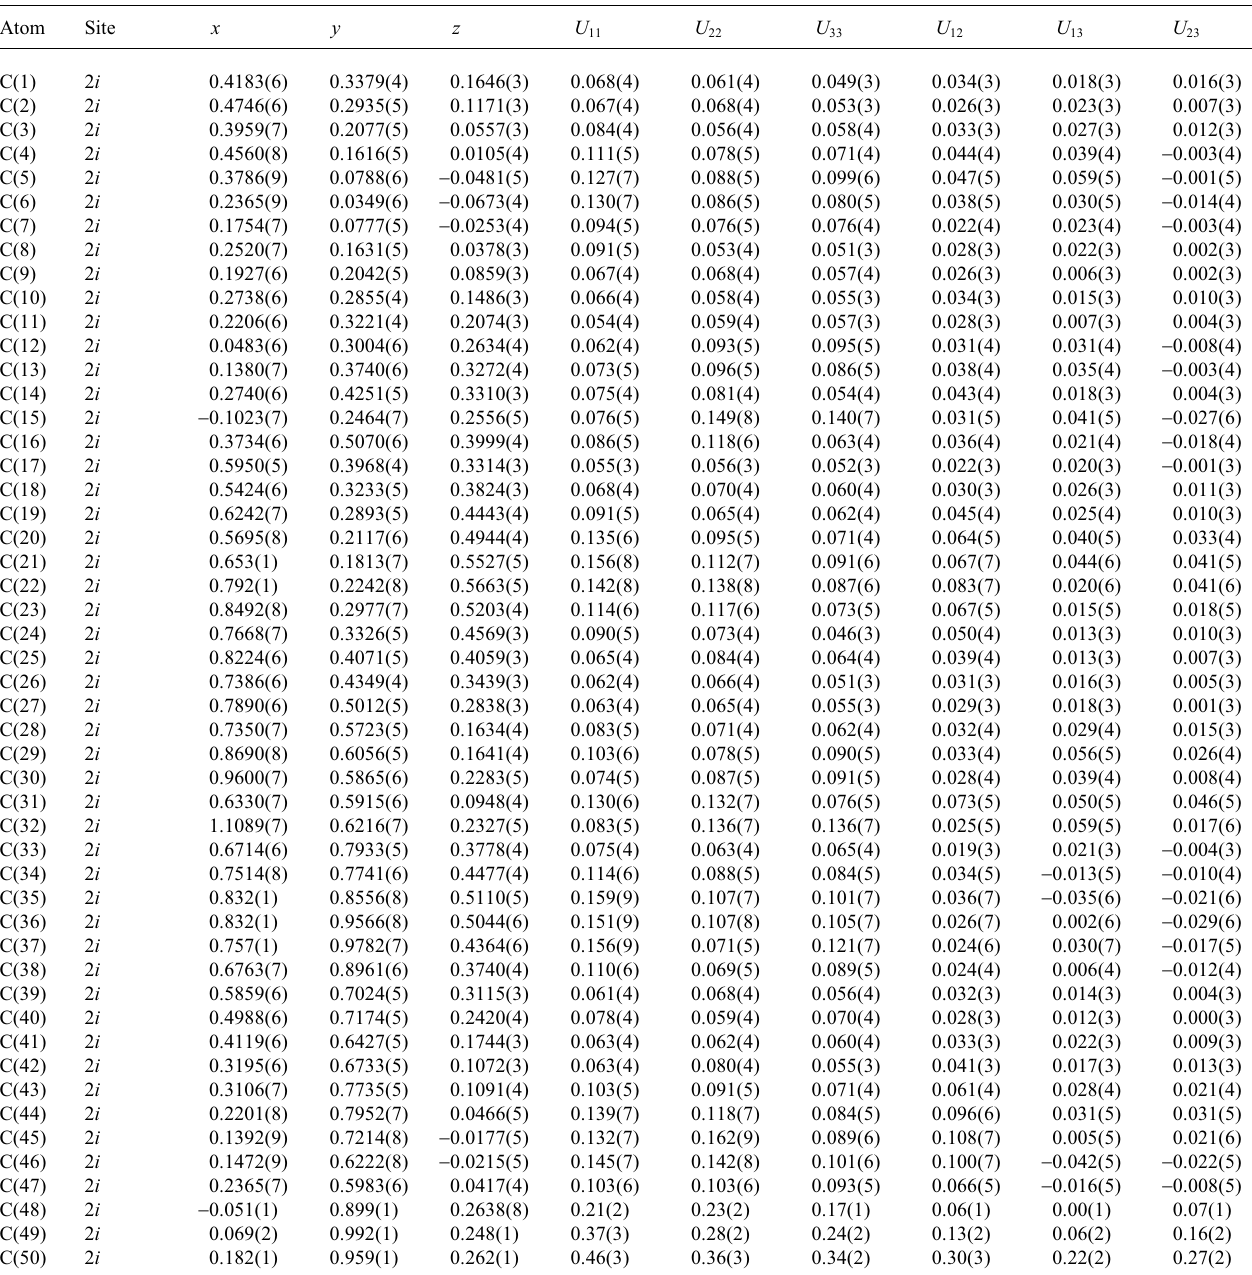
Table 3. Atomic coordinates and displacement parameters (in Å 2